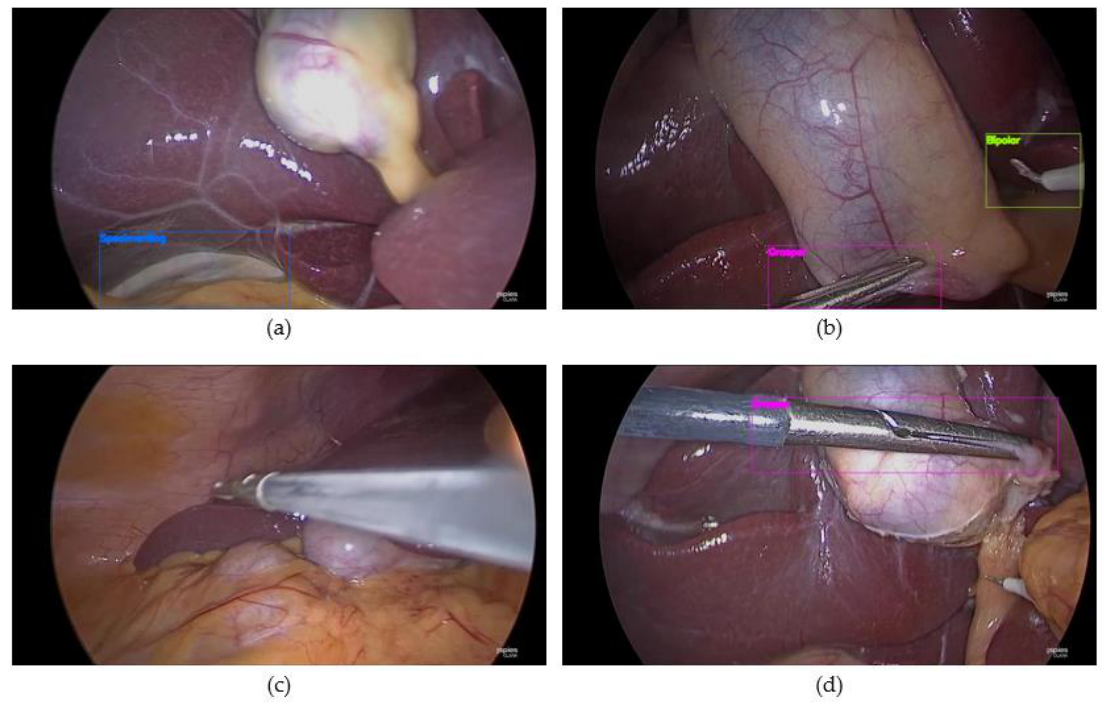
Figure 6. Example of errors in surgical tools detection using YOLO9000 only ( a ) and ( b ) false positive, ( c ) and ( d ) false negative. ( c , d ) false